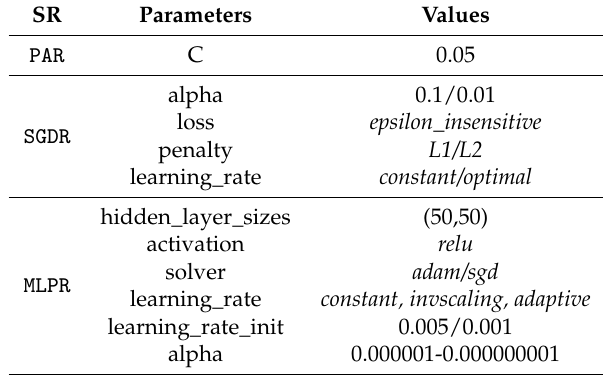
Table 8. Hyper-parameter tuning results for SRs in the experiment